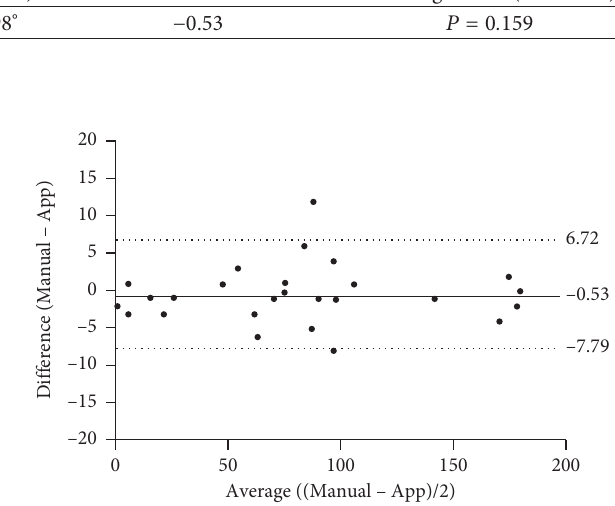
Table 1: Comparison between the application and the manual method in relation to the measurements of the IOL angle (target axis). Angle